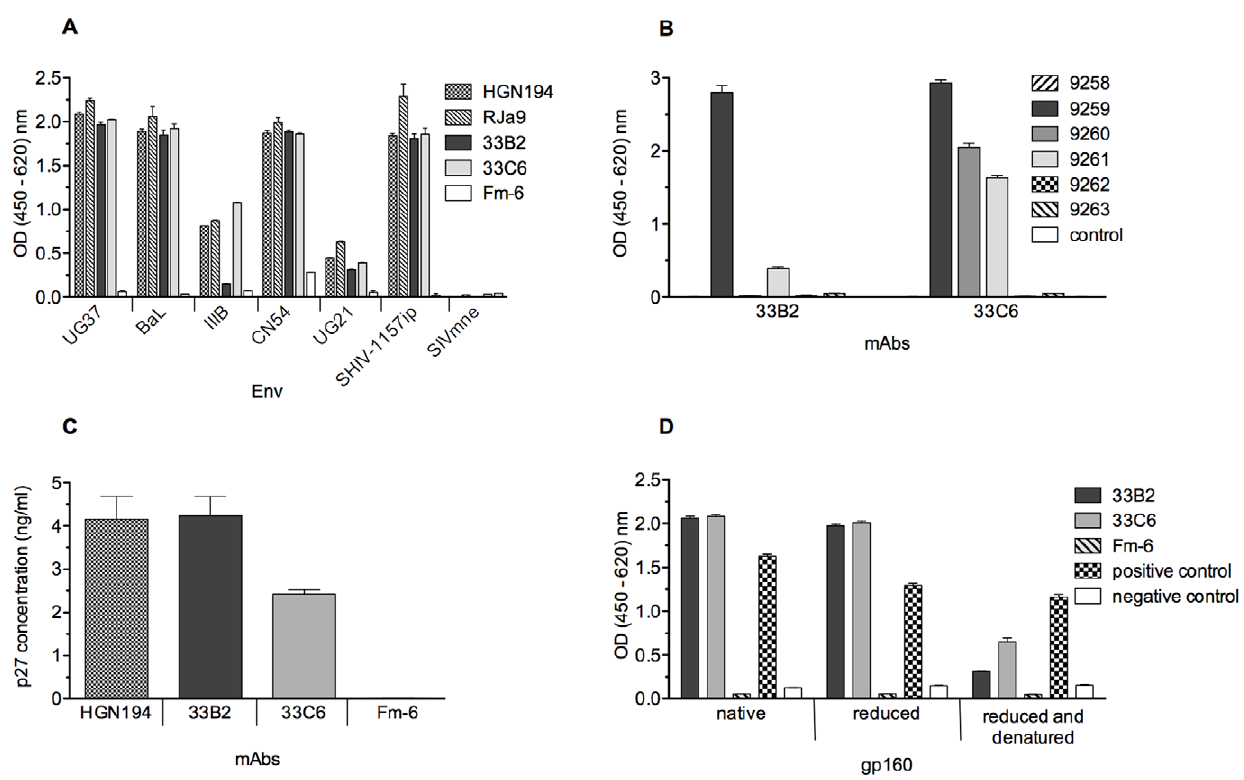
Figure 5. Properties of mAbs 33B2 and 33C6. (A) Binding to envelope proteins of different HIV clades. Plates were coated with Env proteins and probed with newly isolated mAbs along with isotype controls (positive control, HGN194 [16]; negative control, Fm-6 [37]) and cognate rhesus monkey (RJa-9) serum. HIV Env proteins were derived from the following strains: clade A, UG37; B, BaL and IIIB; C, CN54 and 1157ip (the latter is a simian-human immunodeficiency virus (SHIV) strain encoding an HIV clade C envelope [25]; D, UG21. SIVmne gp160 was used as negative control. (B) Epitope mapping. Bars show Ab binding by ELISA to consensus HIV clade C peptides representing the V3 loop region. The control peptide represents the scrambled C-terminal sequence of SHIV-1157ip gp120. (C) Virion binding assay. MAbs 33B2 and 33C6 along with negative control (Fm-6) and positive control (HGN194) were captured on the plate coated with goat anti-human IgG Fc-specific Ab and then exposed to SHIV-1157ipEL-p [19] virions. The amount of virus bound to mAbs was assessed by p27 Gag ELISA. (D) Binding of mAbs 33B2 and 33C6 with native and denatured HIV CN54 gp120. Plates were coated with native, reduced or reduced/denatured HIV Env protein and probed with 33B2 and 33C6 along with Fm-6 (negative control mAb) as well as serum of HIV-positive individual (positive control), and serum of HIV-negative individual (negative control). We used tris